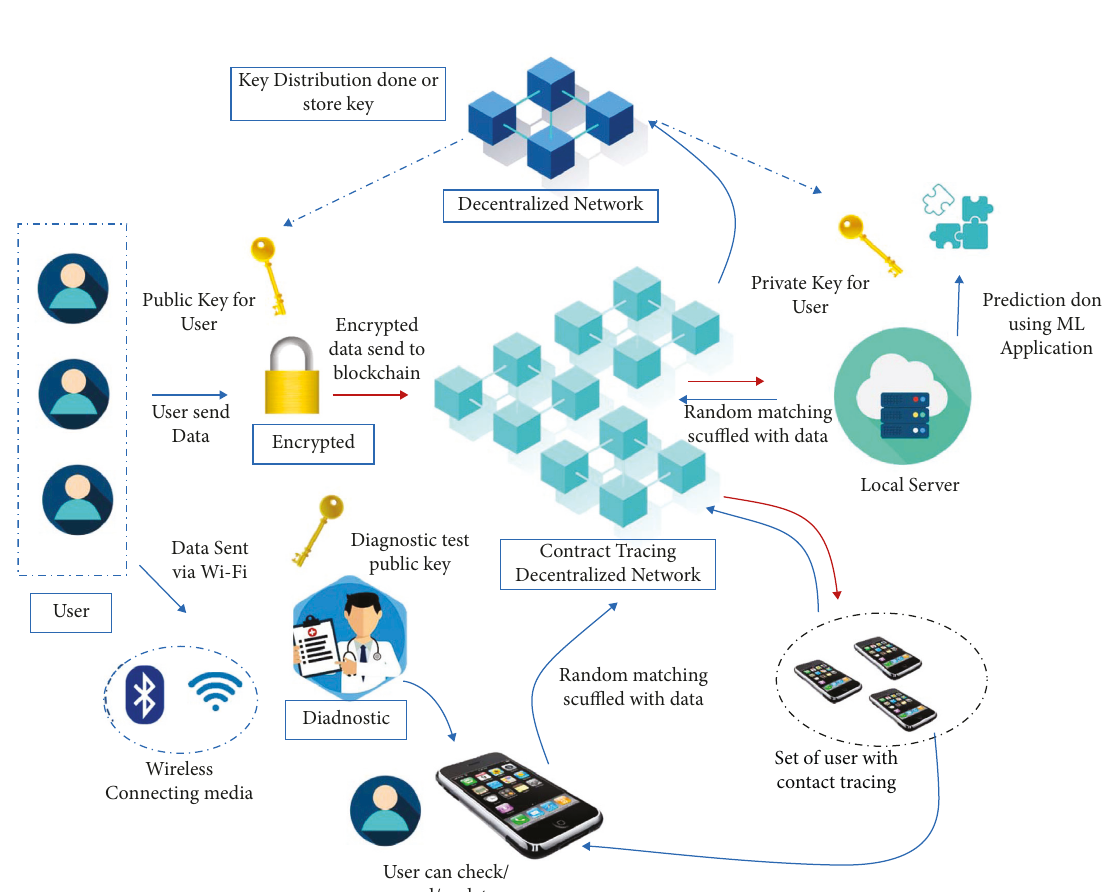
Figure 5: Proposed blockchain-based architecture for contactless monitoring.